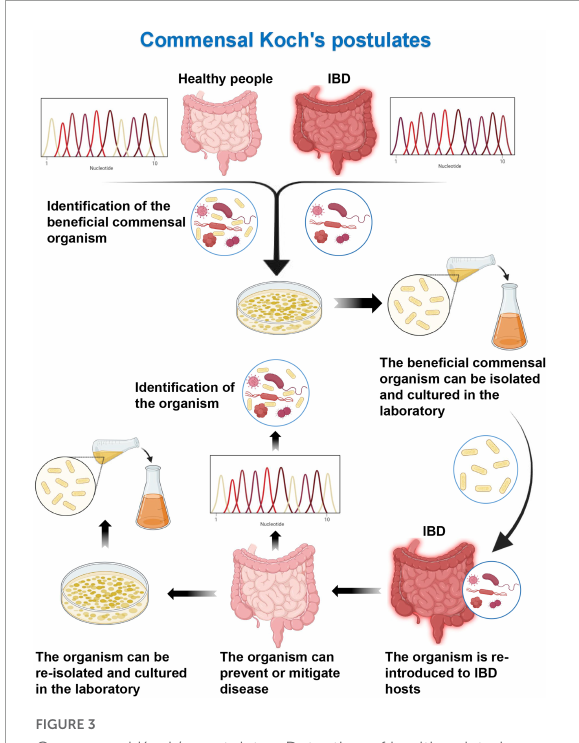
FIGURE3 Commensal Koch’s postulates. Detection of health-related specific beneficial commensal microorganisms by sequencing in healthy individuals and inflammatory bowel disease (IBD) patients. The beneficial commensal organism can be isolated and cultured in the laboratory. Then the organism can prevent or mitigate disease when it is re-introduced to IBD hosts. The commensal organism can be detected and re-isolated from healthy recovered